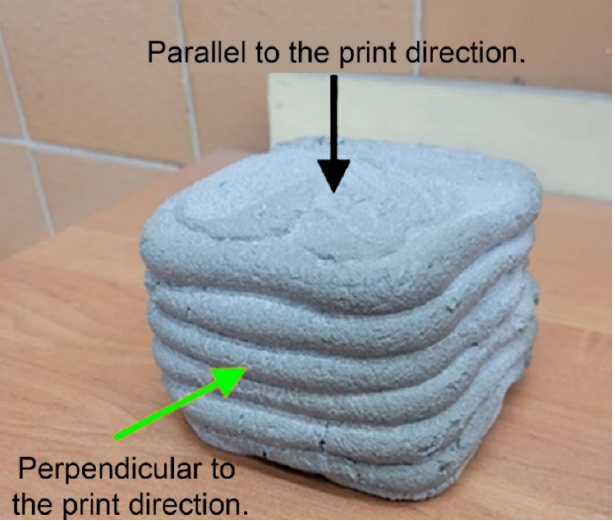
Figure 1. Scheme of applied testing directions for the compressive strength of printed samples.